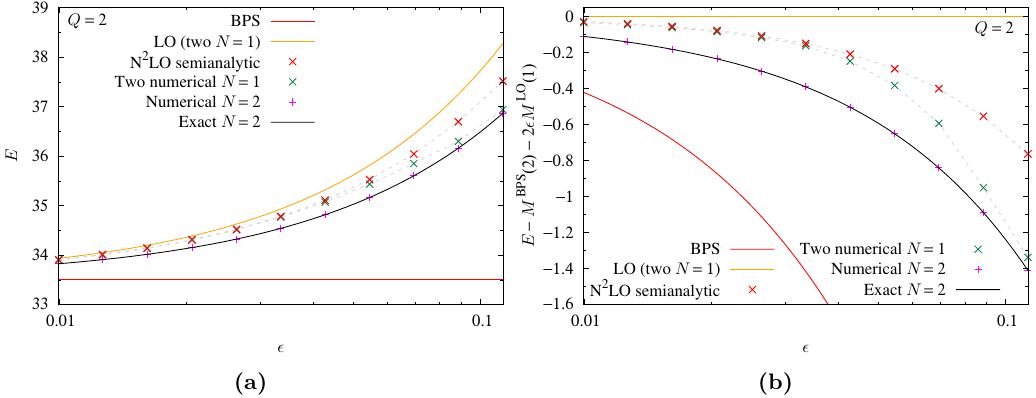
Figure 20 . The energy (a) and N 2 LO perturbation energy of the metastable solution in the Q = 2 homotopy class, which is made of two N = 1 compactons with separation distance 2 a = 0 . The total energy (a) shows the BPS energy (red), the LO correction from the kinetic term of order (cid:15) (orange), the full N 2 LO perturbation energy obtained by PDE calculations (red crosses) in comparison with the full numerical PDE calculations of the solutions without perturbation theory (green crosses), and for reference the full numerical PDE solutions of the axially symmetric N = 2 baby Skyrmions (magenta pluses) as well as the exact N = 2 baby Skyrmions obtained by ODEs, all as functions of (cid:15) . (b) shows the N 2 LO part of the energy only, so as to better see the accuracy of the comparison between the full numerical PDE energies (green crosses) and the N 2 LO perturbative energies (red crosses) as functions of (cid:15)